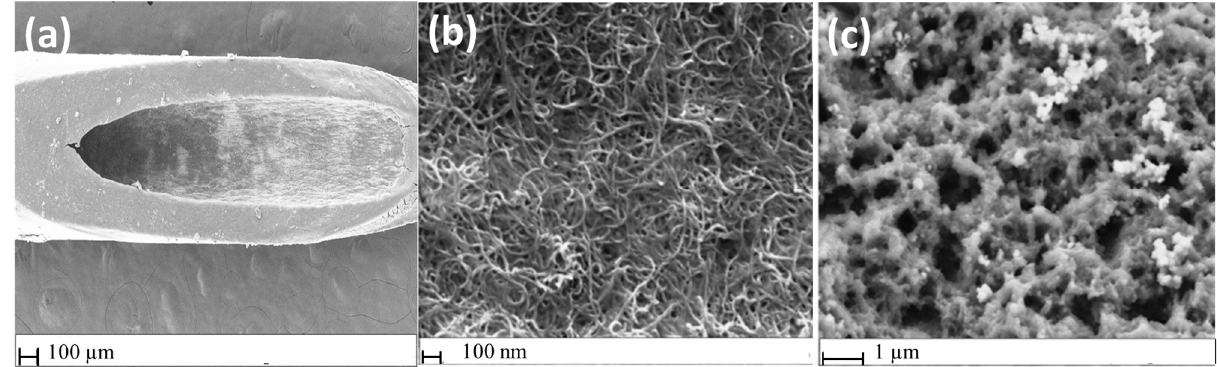
Figure 2. SEM images of ( a ) CNT/CNC coated MN; ( b ) magnified CNT/CNC coated MN; and ( c ) magnified PANI@CNT/CNC SPME MN.